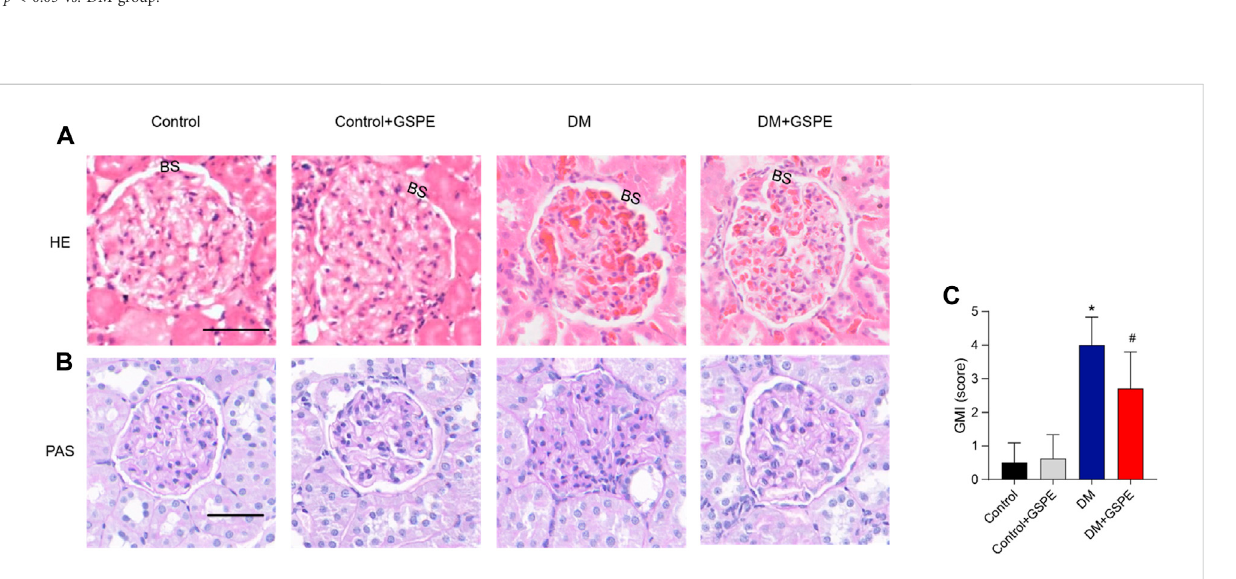
FIGURE 2 Histopathologyevaluationofthekidneysofallrats fromallexperimentalgroupsas stainedbyHEand PASstaining.Upperpanel (A) represented images stained by HE (original magni fi cation, ×200). Lower panel (B,C) showed images stained by PAS (Scale bars, 50 μ m Original magni fi cation,×200)andtheanalysisoftheGMI(Mean±SD.n=6. p p < 0.05vs.control;# p < 0.05vs.DMgroup).Theimagesofcontrolandcontrol + GSPE-treated rats showed normal kidney structures with normal glomerulus, normal size Bowman ’ s space (BS). The images of DM rats showed obvious mesangial expansion and glomerulosclerosis. Note the increase in the capsule as well as in Bowman ’ s space. The images of DM